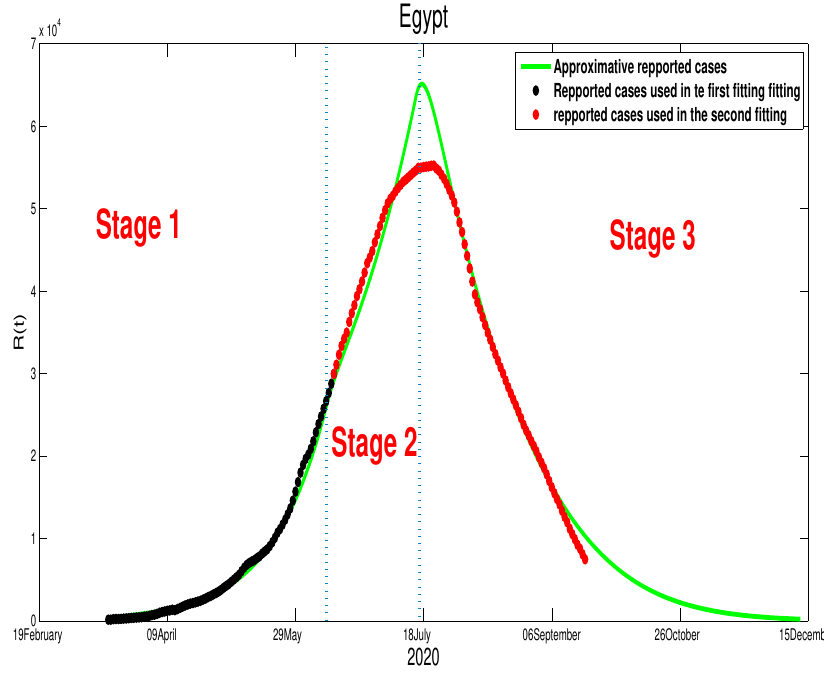
Figure 14. The evolution of the infection cases in Egypt after the relaxation of the population mobility restrictions.